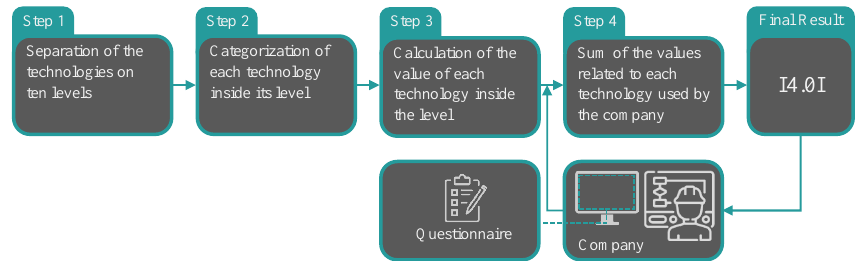
Figure 2. High level abstraction of our paper’s block